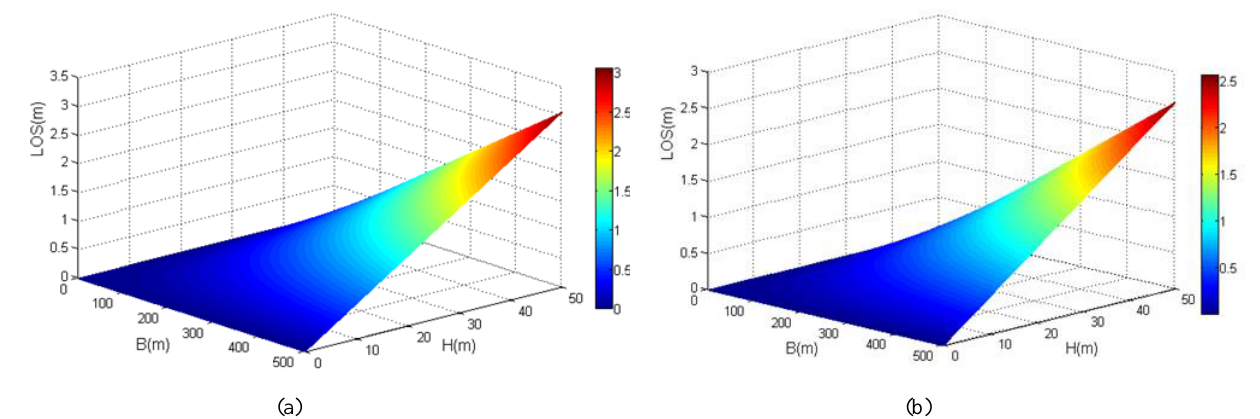
Figure 4.The relation betweenthe accuracy of InSAR line-of-sight(LOS) surface deformation measurement andthe error value of geography for (a) TerraSAR and (b)